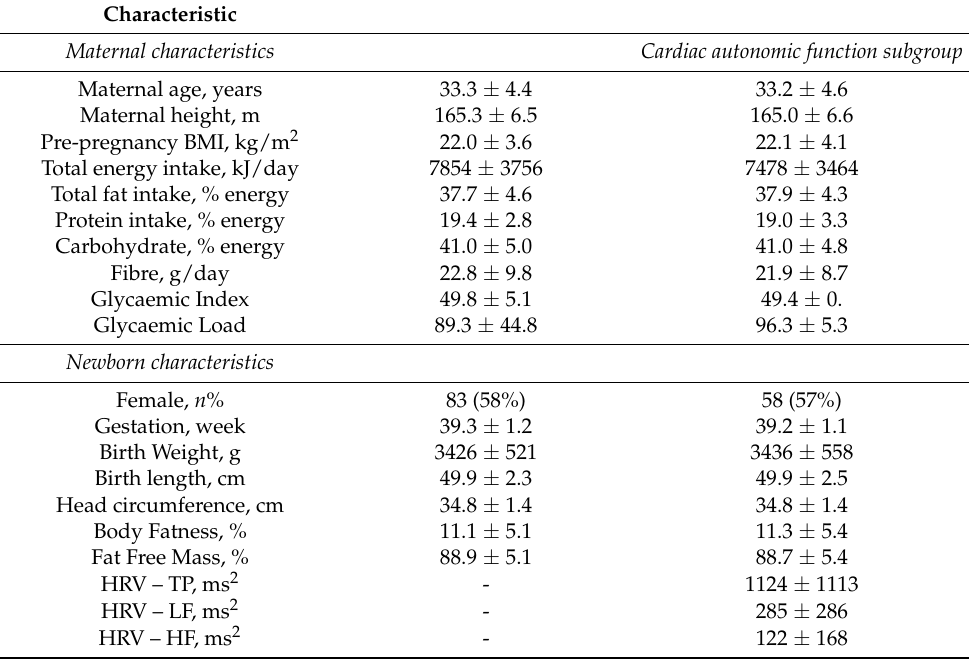
Table 1. Maternal characteristics, including diet, and neonatal